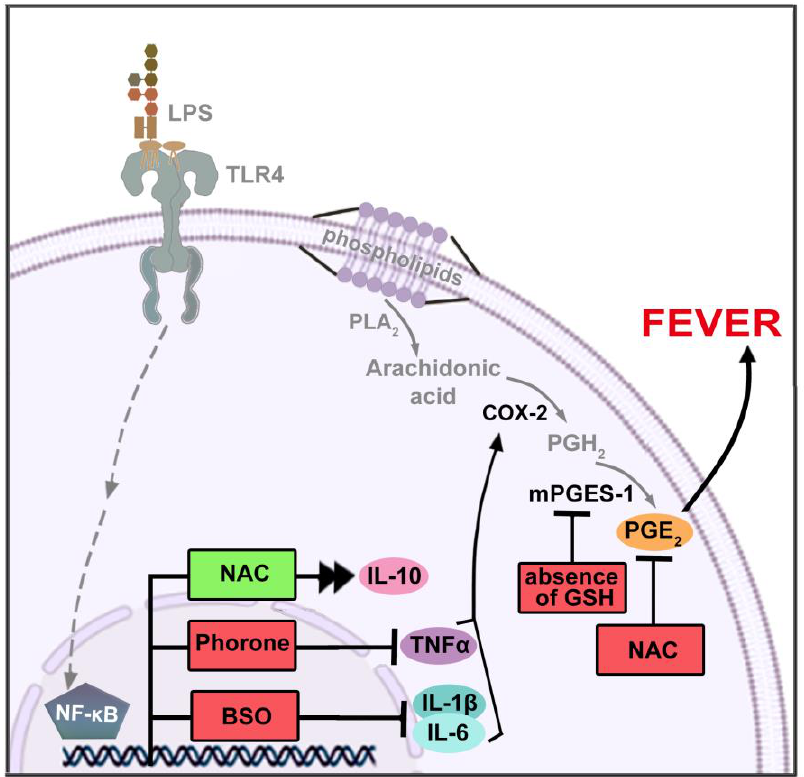
Figure 4. The effect of glutathione (GSH) and its modulators on the mechanism of fever. Detailed description of the fever mechanism is presented in Figure 1. The influence of glutathione and its modulators is depicted by double arrowheads and green color (stimulation) or blunt ends and red color (inhibition). N -acetyl-l-cysteine (NAC)—glutathione precursor; buthionine sulfoximine (BSO) and phorone—glutathione depletors.